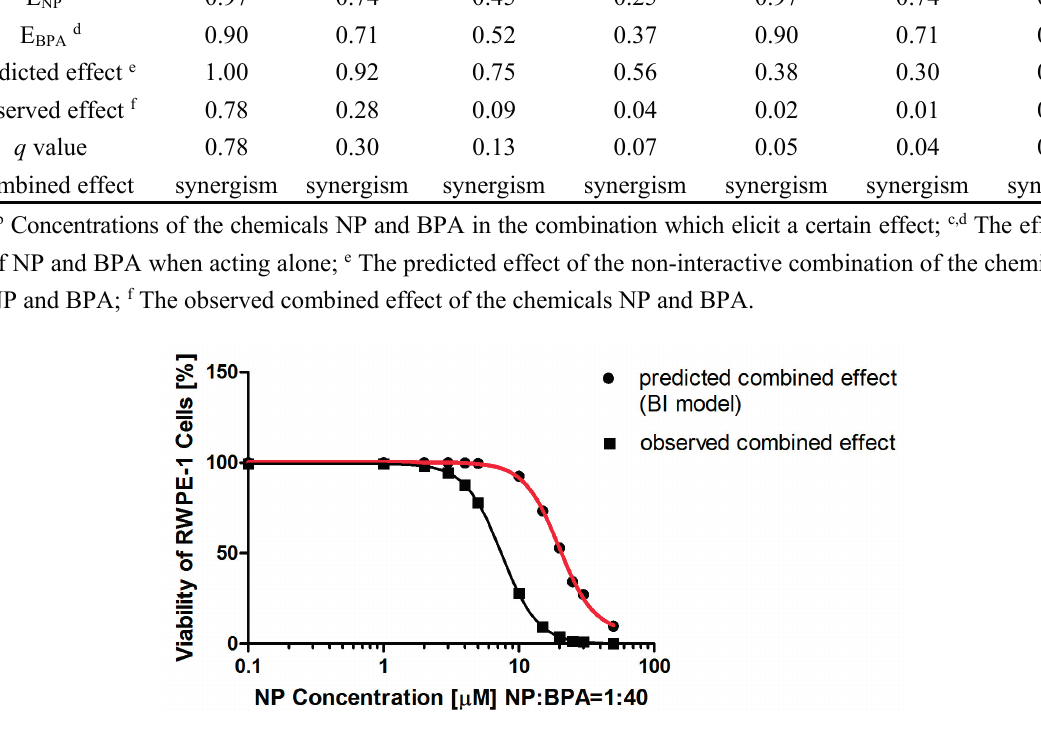
Figure 3. Comparison of observed and predicted cell viability caused by a combination of nonylphenol (NP) and bisphenol A (BPA). The predicted concentration-response curve of the mixture matched the data calculated from the Bliss independence (BI) models. Components were mixed in a fixed ratio based on their individual EC50 values. The two curves both satisfied the Hill